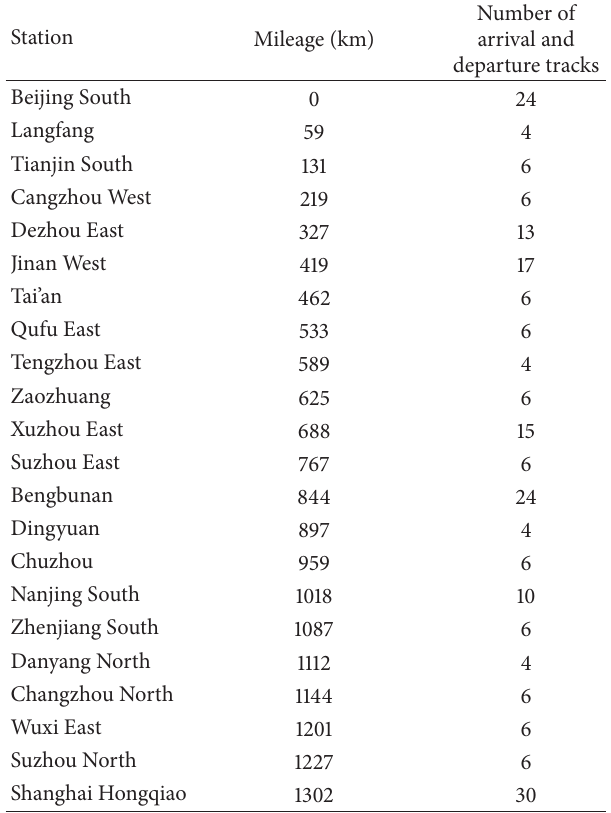
Table 1: Parameters of Beijing-Shanghai high speed